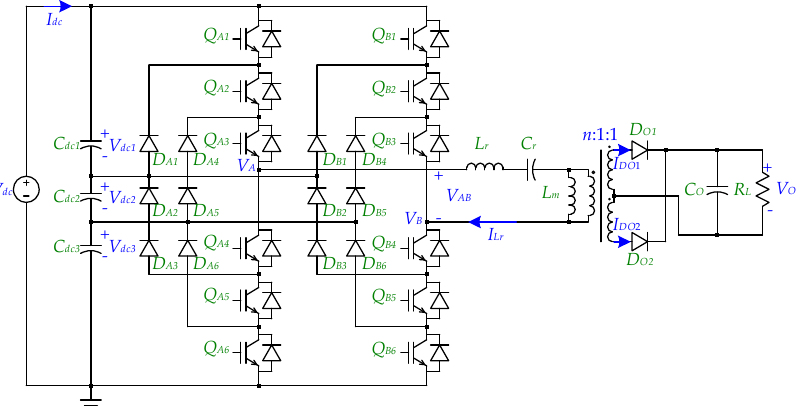
Figure 5. Circuit diagram of the proposed full-bridge diode-clamped four-level LLC converter.